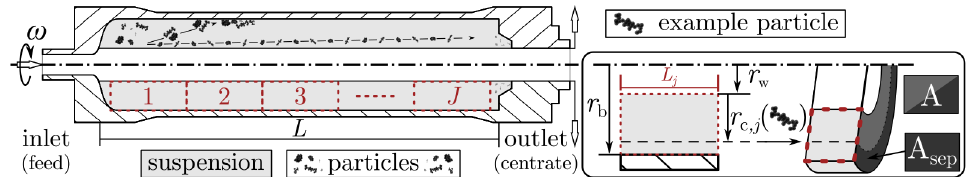
Figure 2. Schematic cross section of a tubular centrifuge rotor highlighting the geometry and spatial discretization with j = { 1,2, . . . , J } cylindrical compartments of equal